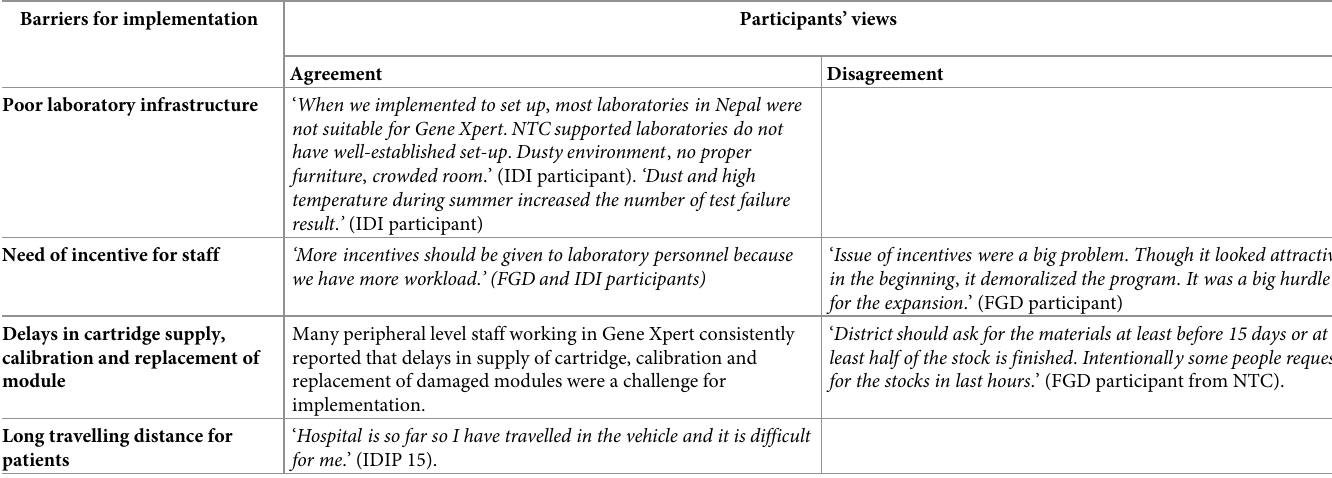
Table 4. Barriers to